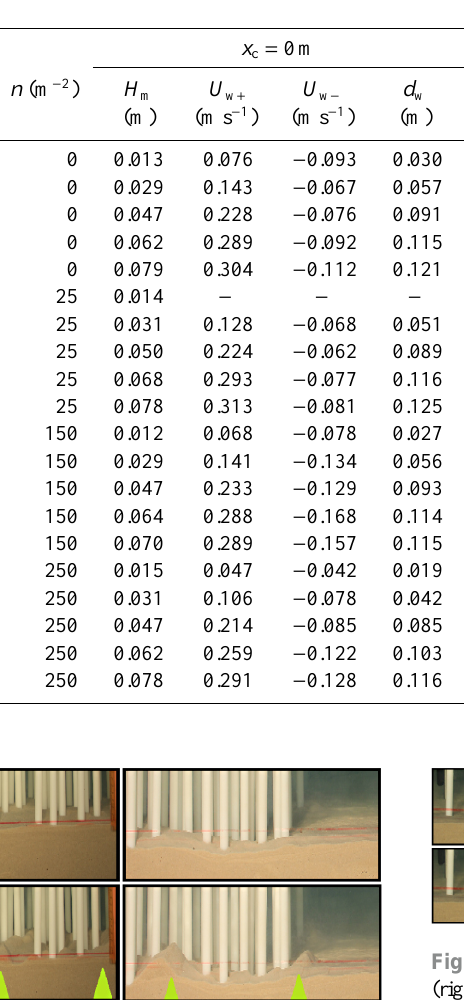
Table 2. Wave parameters for all densities at locations x c = 0m and x c = 3m.